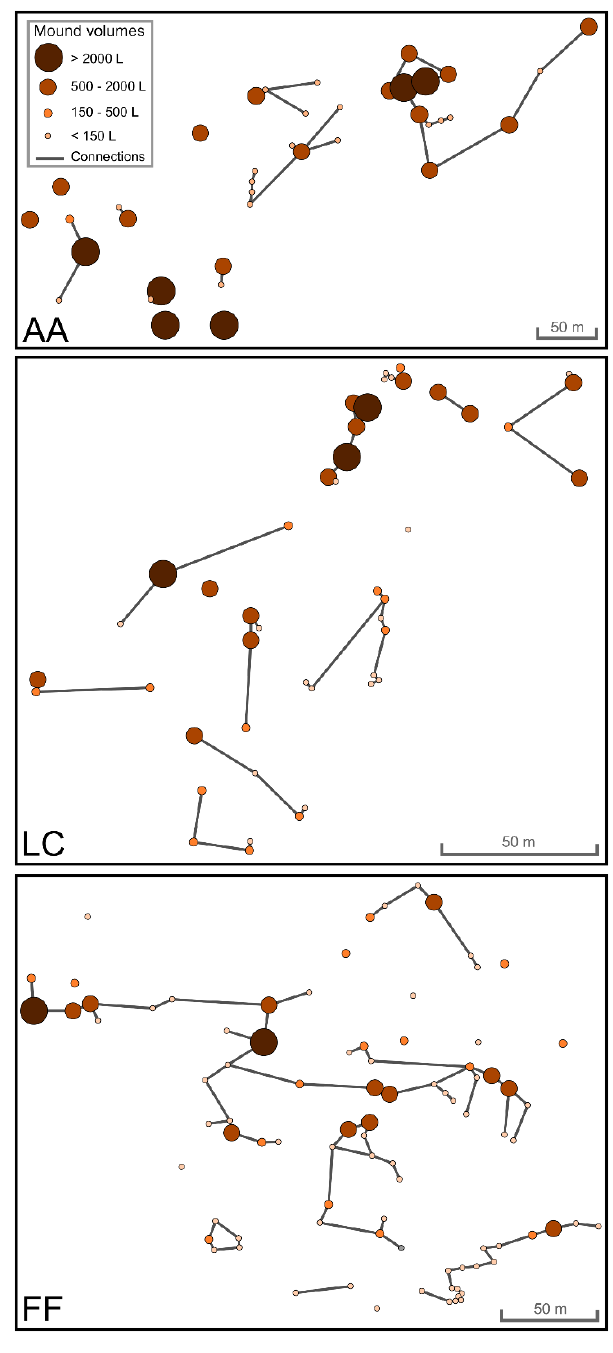
Figure 3. Map of nest network connections (lines) indicating nest size (circle markers) and location at the three sites. AA: Avorniolo Alto, fir–dominated forest; LC: Le Cullacce, mixed forest; and FF: Fosso Fresciaio, beech–dominated forest. The frequency distribution of the SRI index differed among sites ( χ 2 = 29.44, df = 4, p < 0.001, (Figure 4). In particular, FF significantly differed from AA and LC, having a higher amount of low SRI values (i.e., flatter nests). On the contrary, no significant difference was found between AA and LC. These distributions were significantly different between AA and FF ( χ 2 = 8.63, df = 2, p = 0.013) and between LC and FF ( χ 2 = 24.47, df = 2, p < 0.001), but not between AA and LC ( χ 2 = 5.80, df = 2, p = 0.055). In these last tests, the significance must be considered with α < 0.017 after the Bonferroni correction for multiple compari- sons.